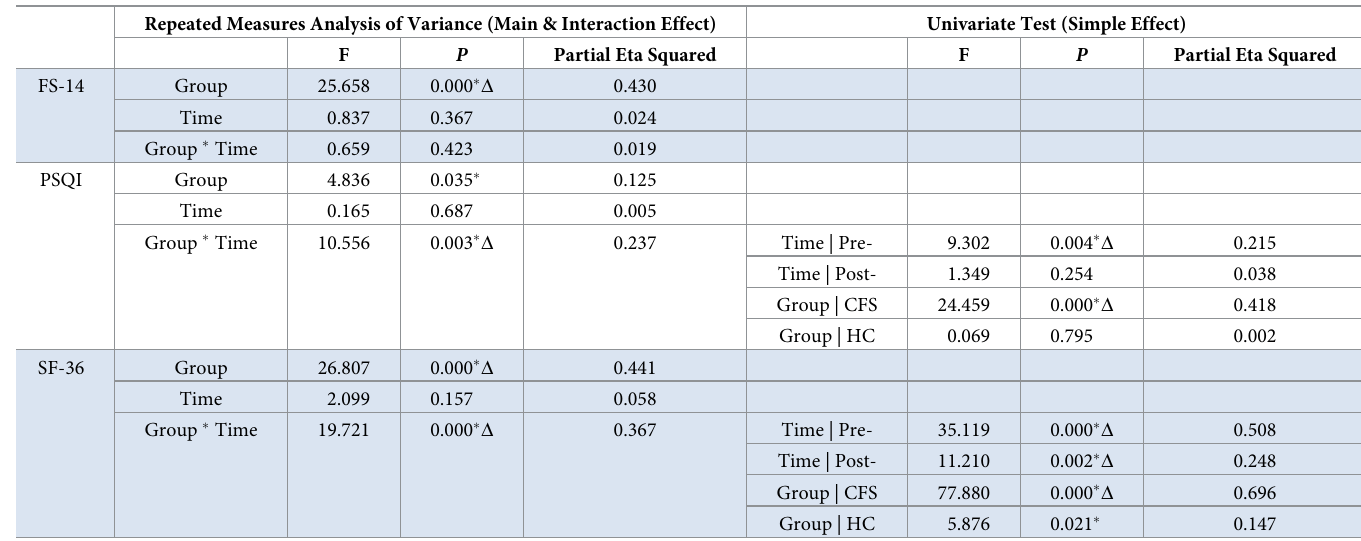
The � represents P value < 0.05; Δ represents P value < 0.016 for multiple correction with Bonferroni method; Group includes CFS and HC groups; Time includes pre- intervention and